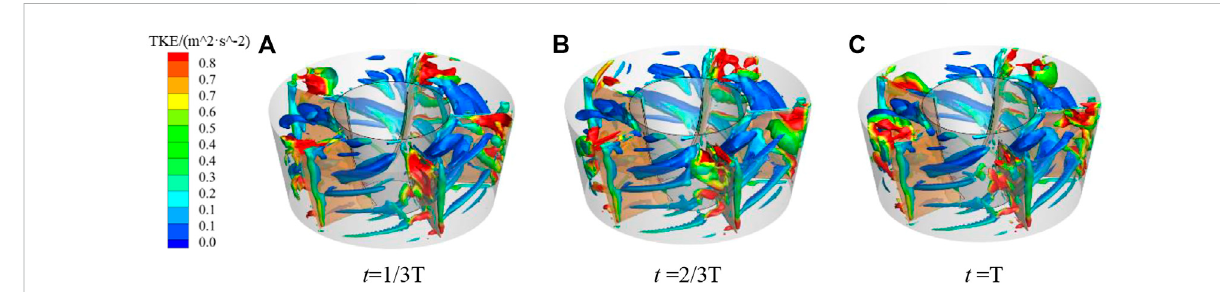
Structure of the vortex of the guide vane body at different moments (1.0 Q d